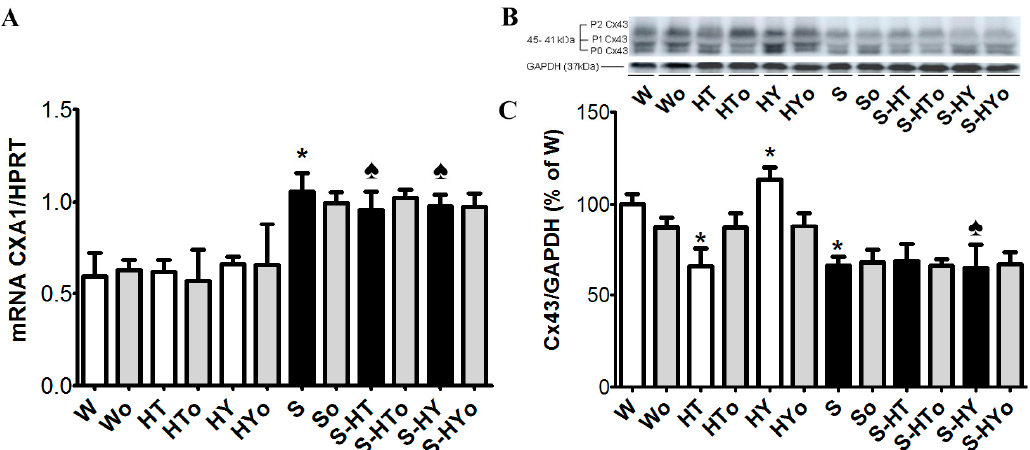
Figure 1. Myocardial expression of CXA1 mRNA normalized to hypoxanthine guanine phosphoribosyl transferase ( HPRT ) level ( A ), and protein abundance of total myocardial connexin-43 (Cx43) normalized to glyceraldehyde-3-phosphate dehydrogenase (GAPDH) protein level ( B and C ) in the male normotensive and hypertensive rats with altered thyroid status with or without feeding with Omacor. W—Wistar Kyoto euthyroid control rats; o—fed with Omacor; HT—hyperthyroid rats; HY—hypothyroid rats; S—spontaneously hypertensive rats; n = 6 in each group. Data are presented as means ± SD; * p < 0.05 vs. W; ♠ p < 0.05 HT vs. S-HT/ HY vs. S-HY.